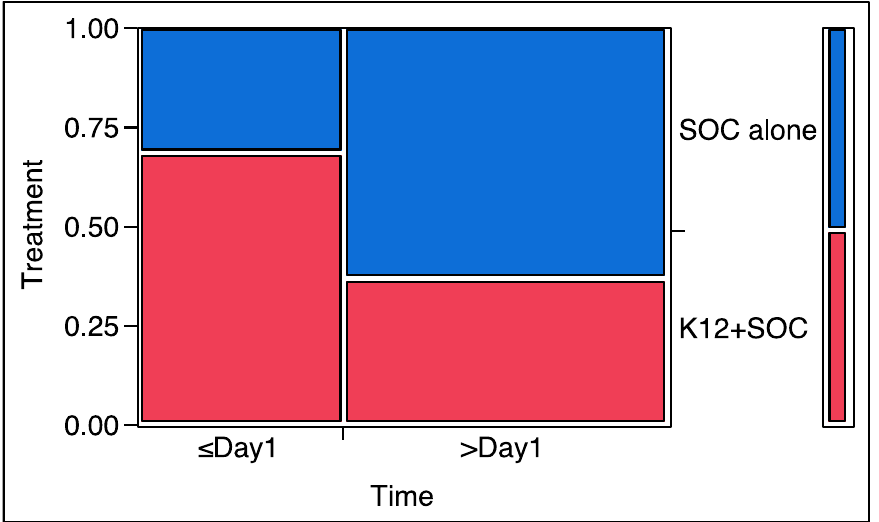
(odds ratio: 3.45098, CI95% 0.793374–15.0109), which means that survival was more than three-times higher in patients treated daily with the S. salivarius K12 strain than in patients not treated with the oral probiotic. To investigate the possible activity of confounding variables (CRP, D-dimer, LDH, Ferritin, and oxygen requirement), whose role could have affected this result, we used the Mantel–Haenszel test. As expected, CRP, D-dimer, LDH, Ferritin, and oxygen need resulted in being significantly correlated (data not shown) with the mortality rate (the higher the value, the higher the risk of death). However, this occurred regardless of the treatment protocol for CRP, D-dimer, LDH, and Ferritin. In contrast, the higher oxygen demand of the patients in the SOC group resulted in being significantly different ( p = 0.0022) from that ascertained for the S. salivarius -K12-treated patients (Table 7).